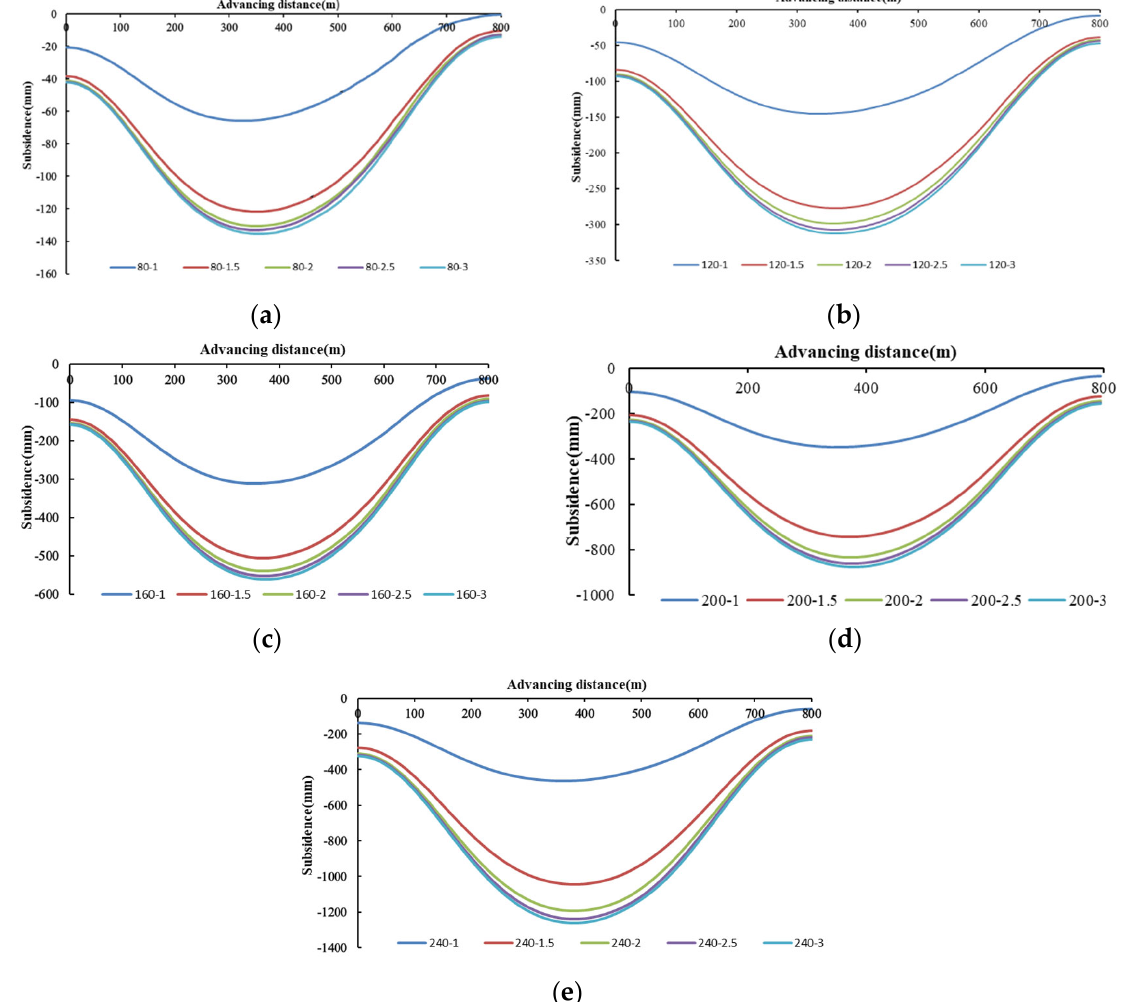
Figure 4. Overburden subsidence curves for the same mining width and different mining heights: ( a ) mining width is 80 m; ( b ) mining width is 120 m; ( c ) mining width is 160 m; ( d ) mining width is 200 m; ( e ) mining width is 240 m .